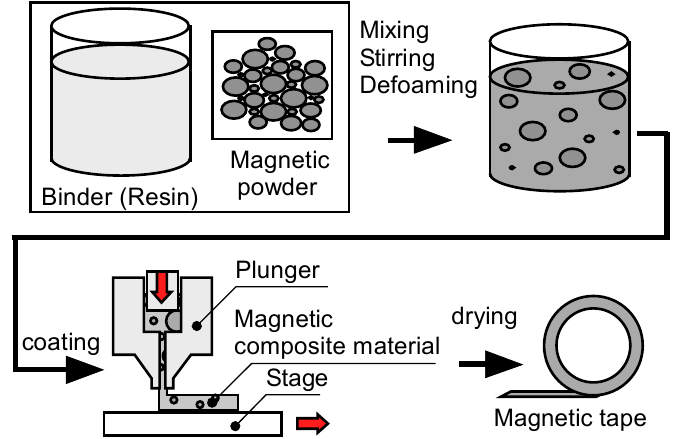
Figure 5. Manufacturing method of the magnetic